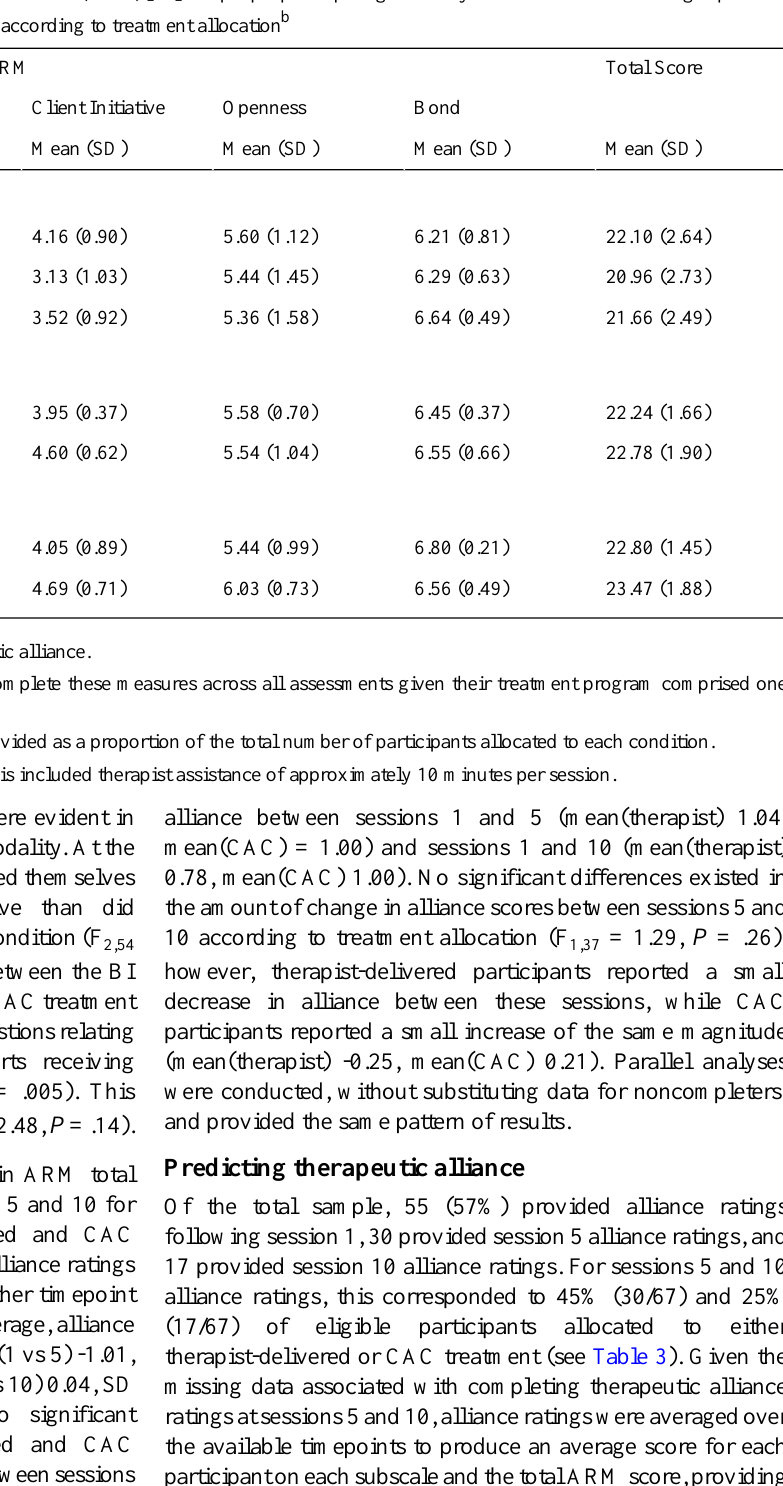
Table 3. Mean subscale scores on the Agnew Relationship Measure (ARM) [26] a for people participating in a study of treatment for coexisting depression and substance use disorders (and their treating clinician), according to treatment allocation b